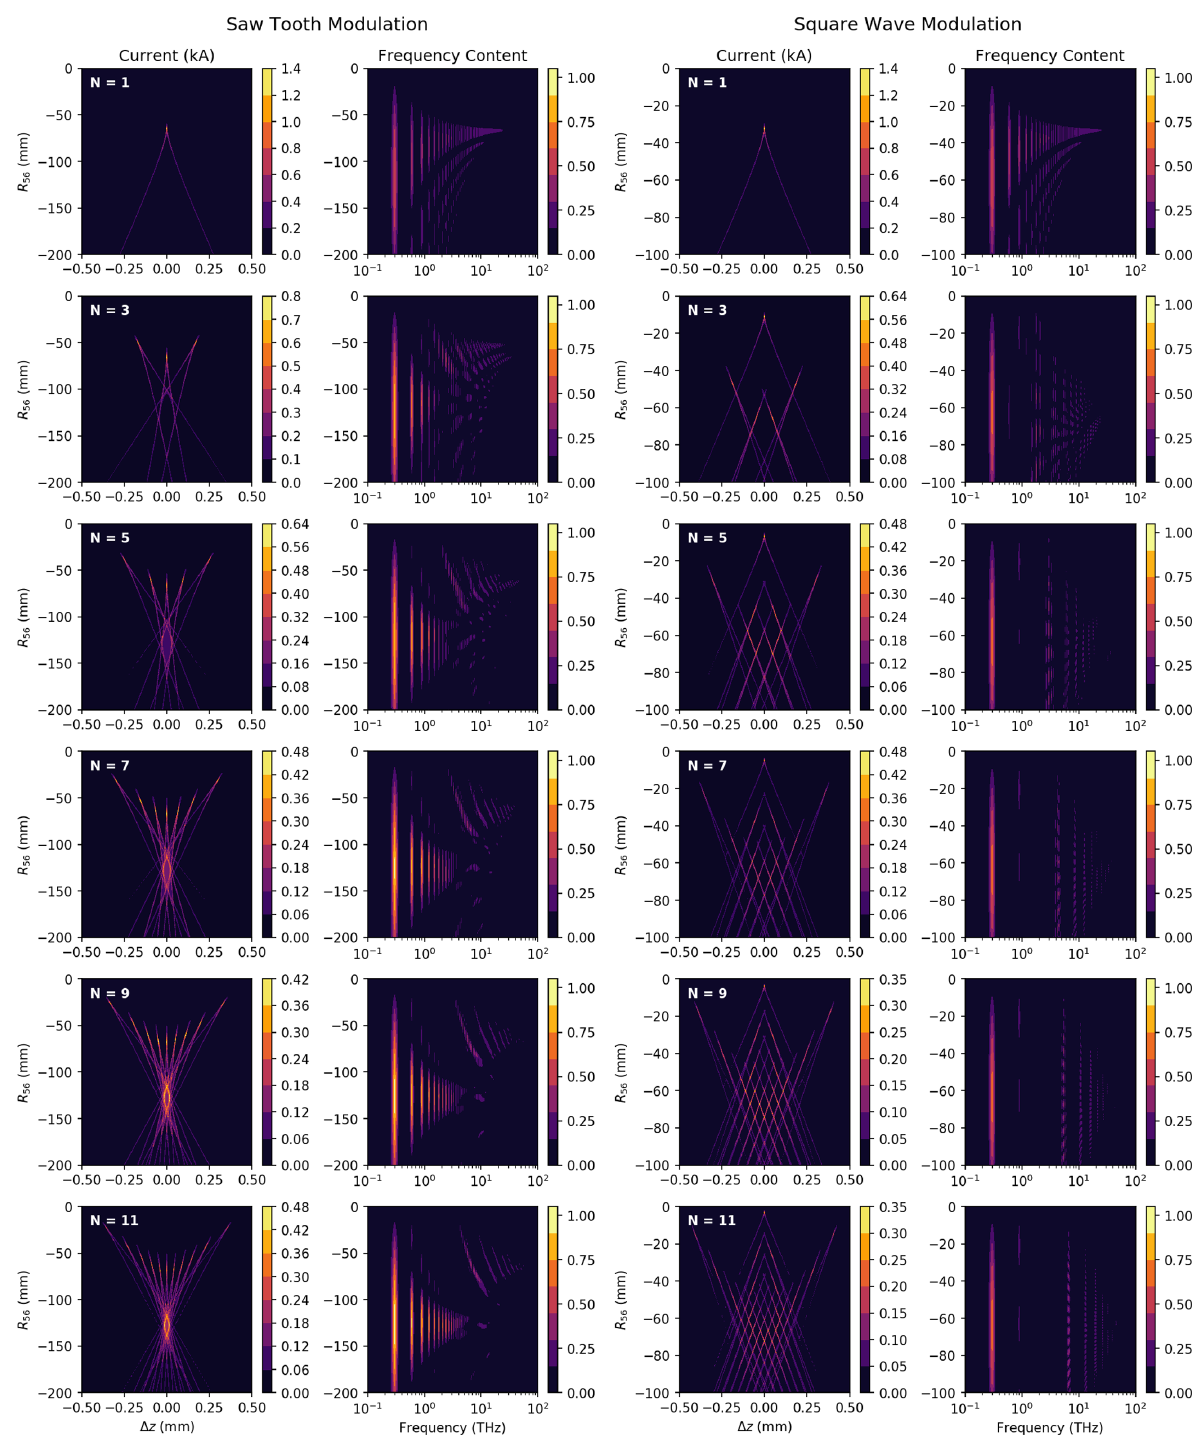
FIG. 4. Contour plots of both the beam current within a single fundamental modulation wavelength λ 0 ¼ 1 mm, as well as the frequency content of the bunch vs the longitudinal dispersion R 56 . Here, Δ z ¼ z − λ 0 = 2 . The scan was performed for N ∈ ½ 1 ; 3 ; 5 ; 7 ; 9 ; 11 (cid:2) . Both a sawtooth modulation according to Eq. (8), as well as a square wave modulation according to Eq. (9) are shown. The idealized input current is assumed to be of flattop shape and the initial energy E 0 ¼ 100 MeV is constant along the bunch. It has a total bunch length of 1 mm and Q ¼ 42 pC. The assumed maximum modulation depth of the lowest frequency component is 500 keV. Note that a high slice energy spread would lead to blurring out the small features in the respective phase spaces. Here we assume a cold beam in order to explore the full mathematical potential of the